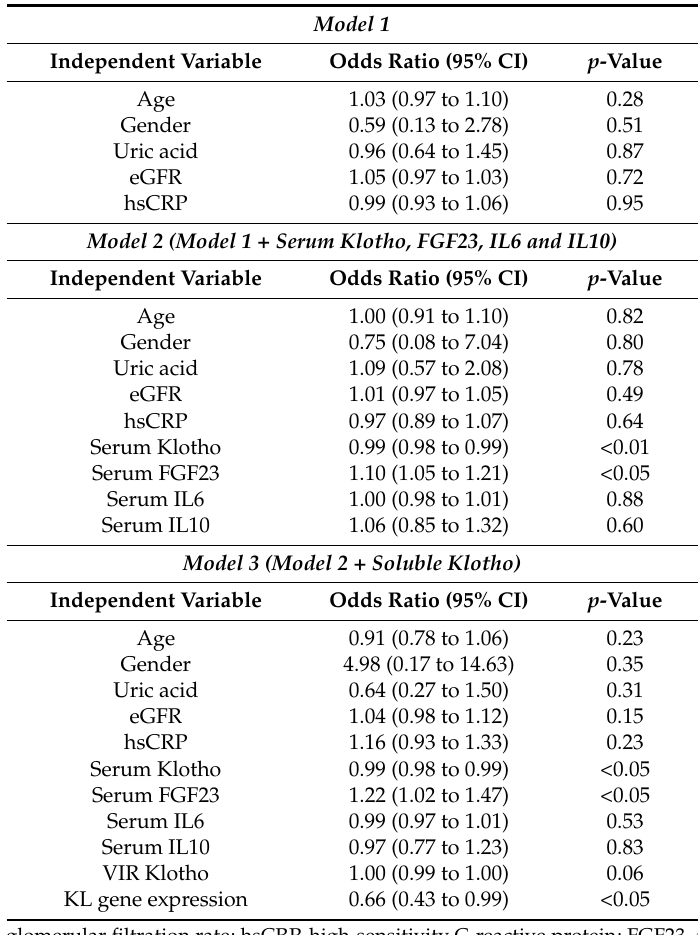
Table 4. Multivariate logistic regression analysis for the presence of